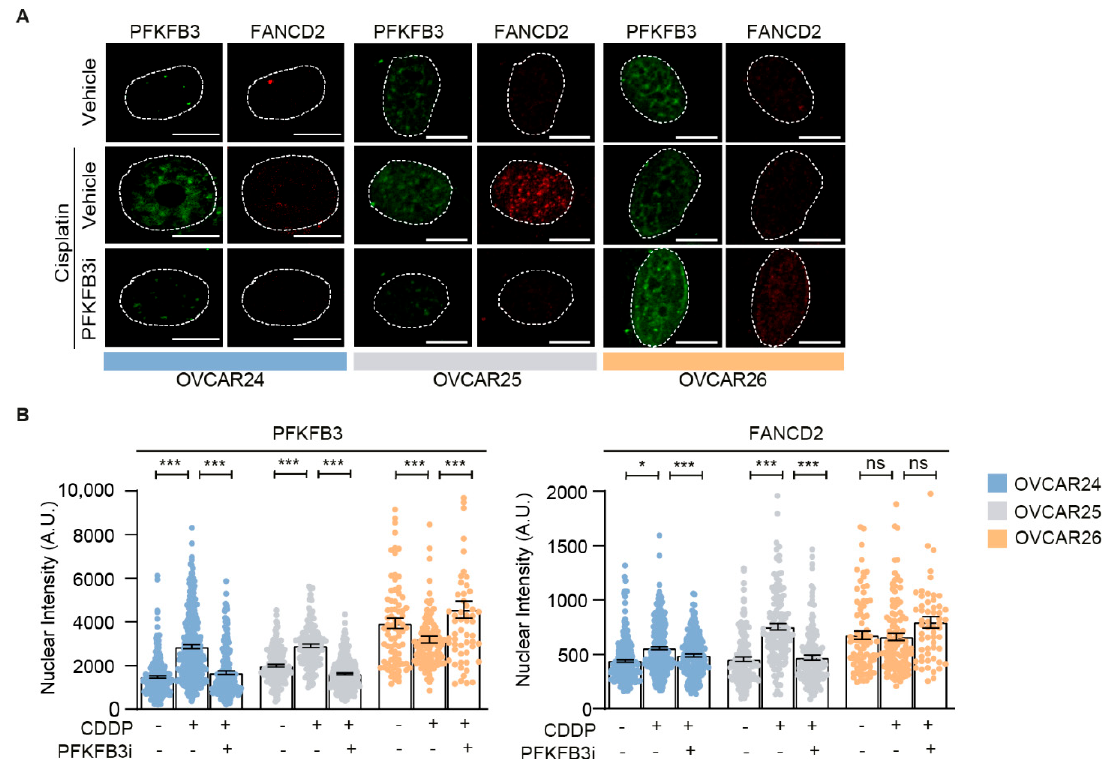
Figure 6. PFKFB3i treatment-induced FA repair defects in ex vivo cell models. ( A ) Representative confocal images of PFKFB3 and FANCD2 nuclear foci in patient-derived ovarian tumor cells, OVCAR24, OVCAR25 and OVCAR26, subjected to cisplatin (CDDP, 10 µM) treatment for 24 h in combination with PFKFB3i (10 µM), or left untreated. n = 2, scale bar = 10 µm. ( B ) Single cell analysis of PFKFB3 and FANCD2 nuclear intensity from ( A ). Data displayed as scatter plot with means ± S.E.M, n = 2 independent experiments, n > 100 cells per condition. * p < 0.05, *** p < 0.001; unpaired two-tailed t -test between conditions.